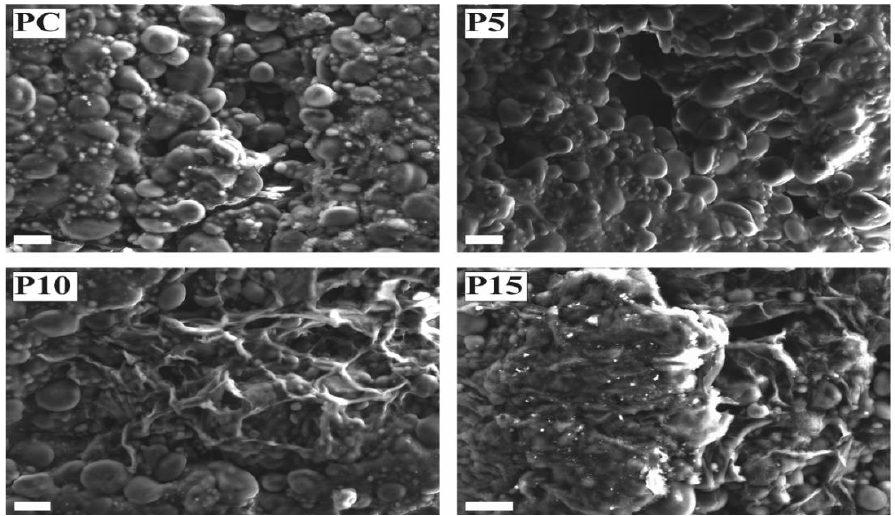
Figure 3. SE-SEM micrographs of control (PC) and inulin enriched (P5, P10, P15) fresh pasta (white bar = 20 µm).